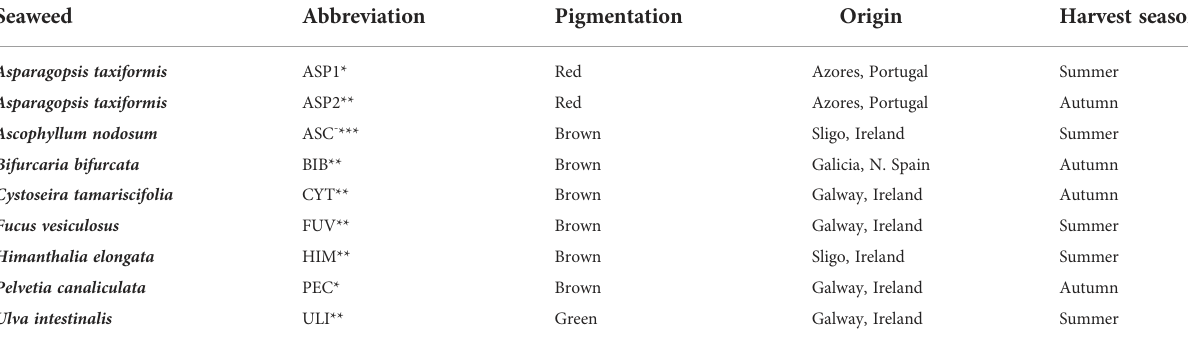
TABLE 1 Abbreviations, pigmentation, origin and harvest season of seaweeds assessed in experiment 1 and 2. Seaweed